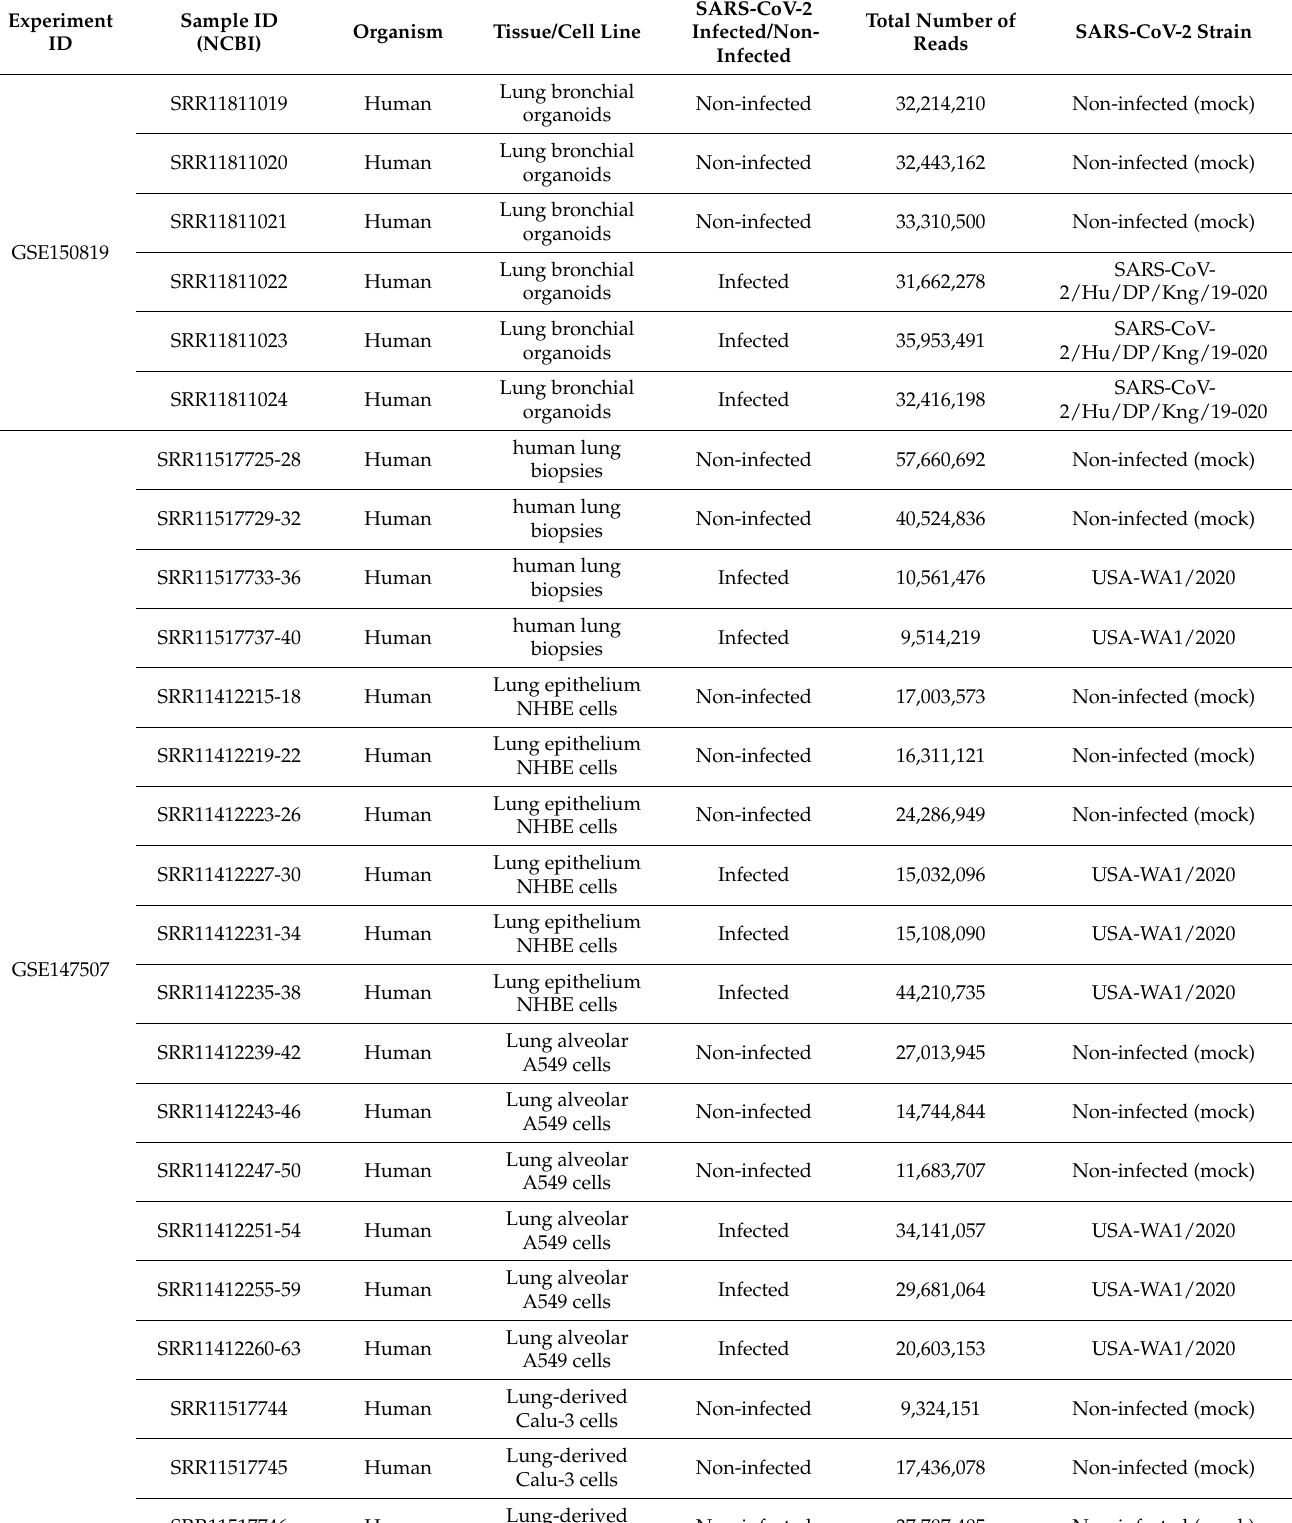
Table 2. Samples (n = 42) used for MIR-5004 expression analysis against SARS-CoV-2 infection. Experiment